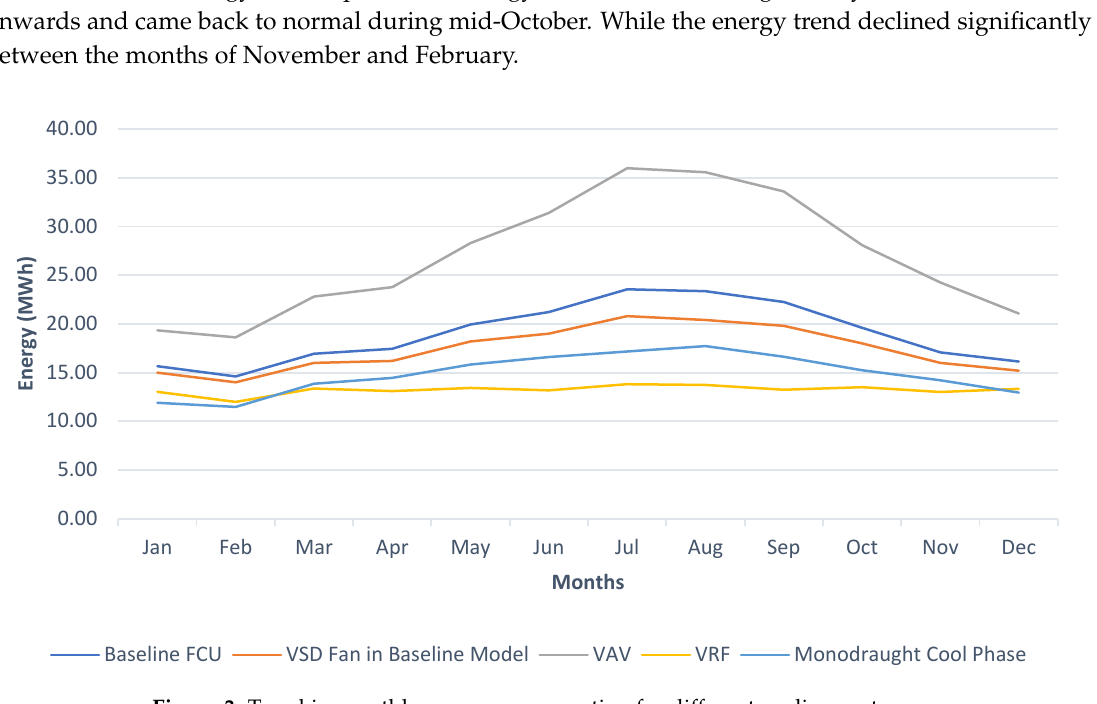
Table 14. Energy and carbon variation due to implementation of different cooling systems.